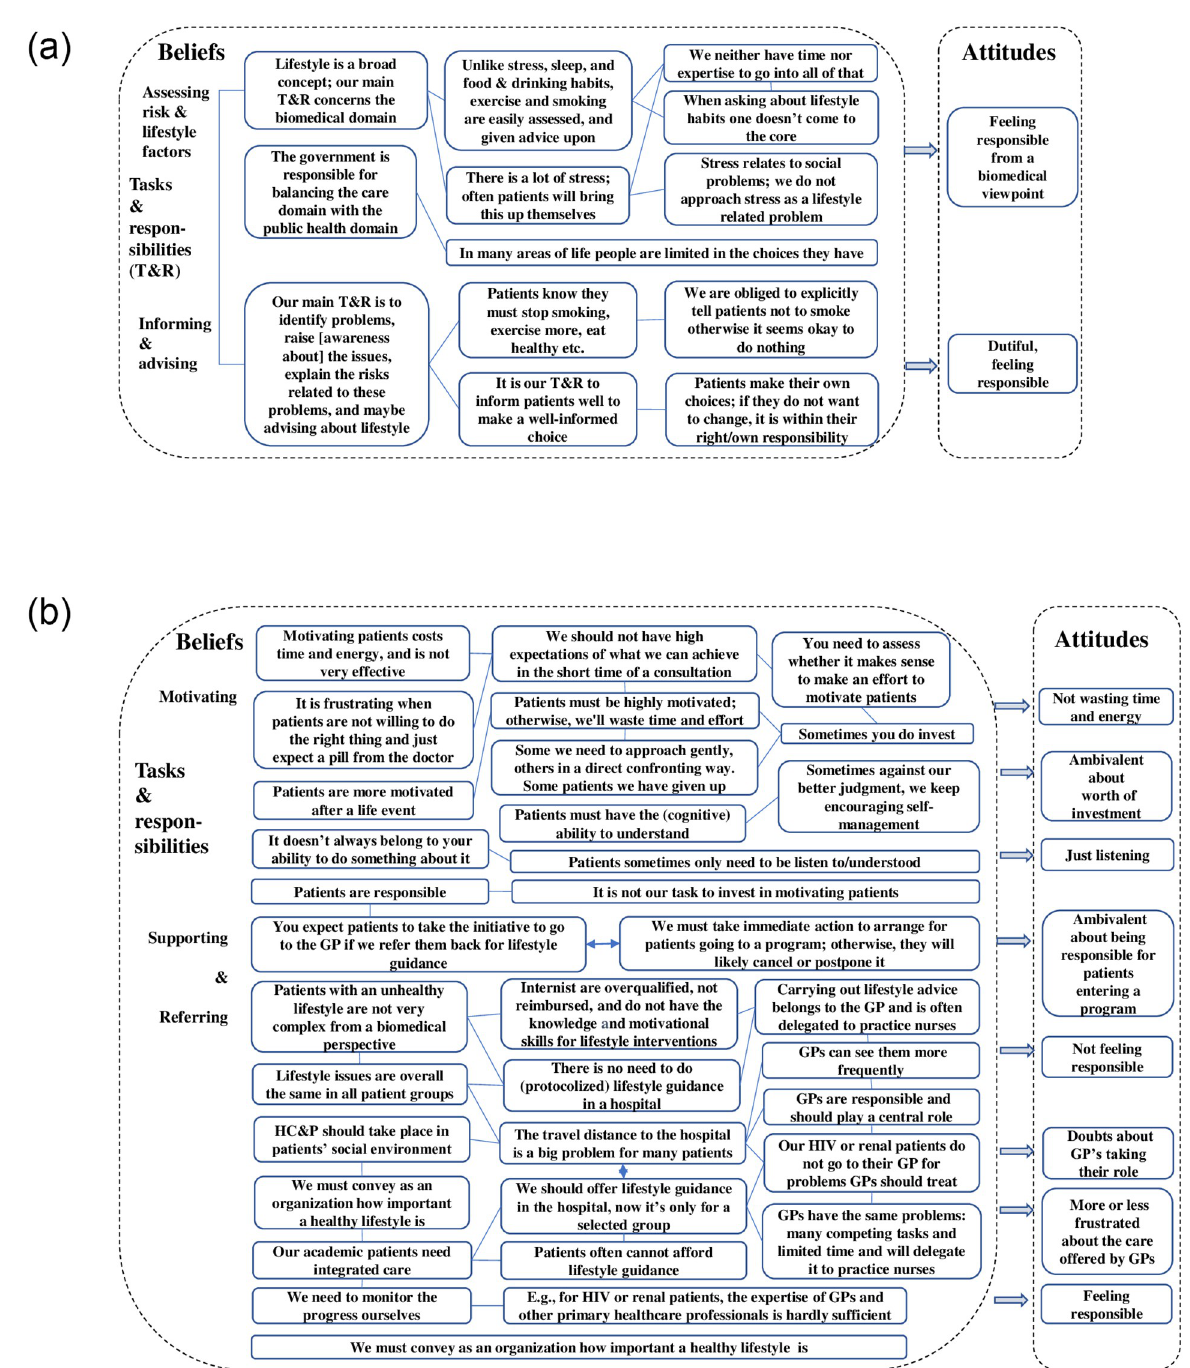
Fig 3. a and b. Schematical overview of beliefs and attitudes about the internists’ tasks & responsibilities in HC&P.